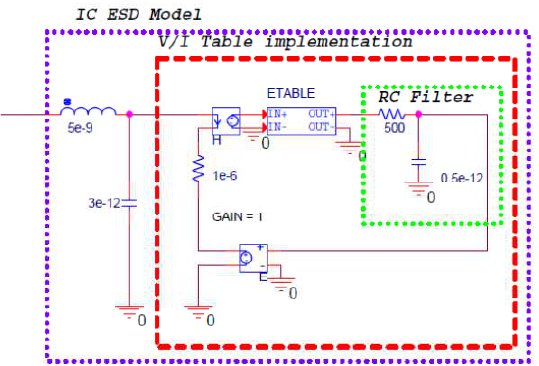
Figure 10: Pspice model suggested in